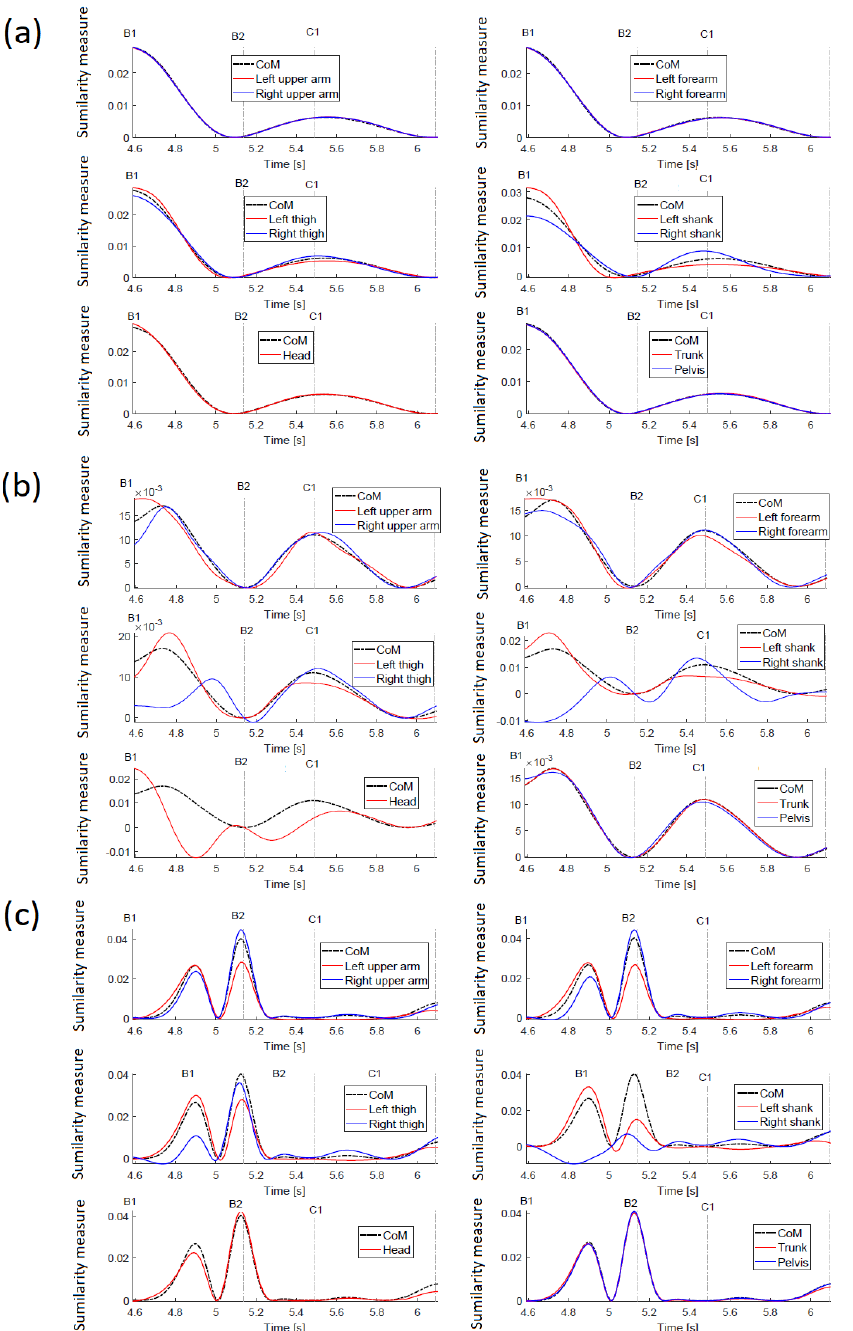
Figure 11. Trajectories of the similarity measure during the push recovery (tied arms). ( a ) trajectories along the X-axis; ( b ) trajectories along the Y-axis; ( c ) trajectories along the Z-axis. The displacement trajectories for this case are shown in Figure 12. Looking at the displacements along the X axis, it is difficult to find differences in the motion trends. For the movements along the Y axis, the displacement of the left thigh is mostly different from the movement of CoM and the other masses, and for displacements along the Z axis, this applies to thigh and